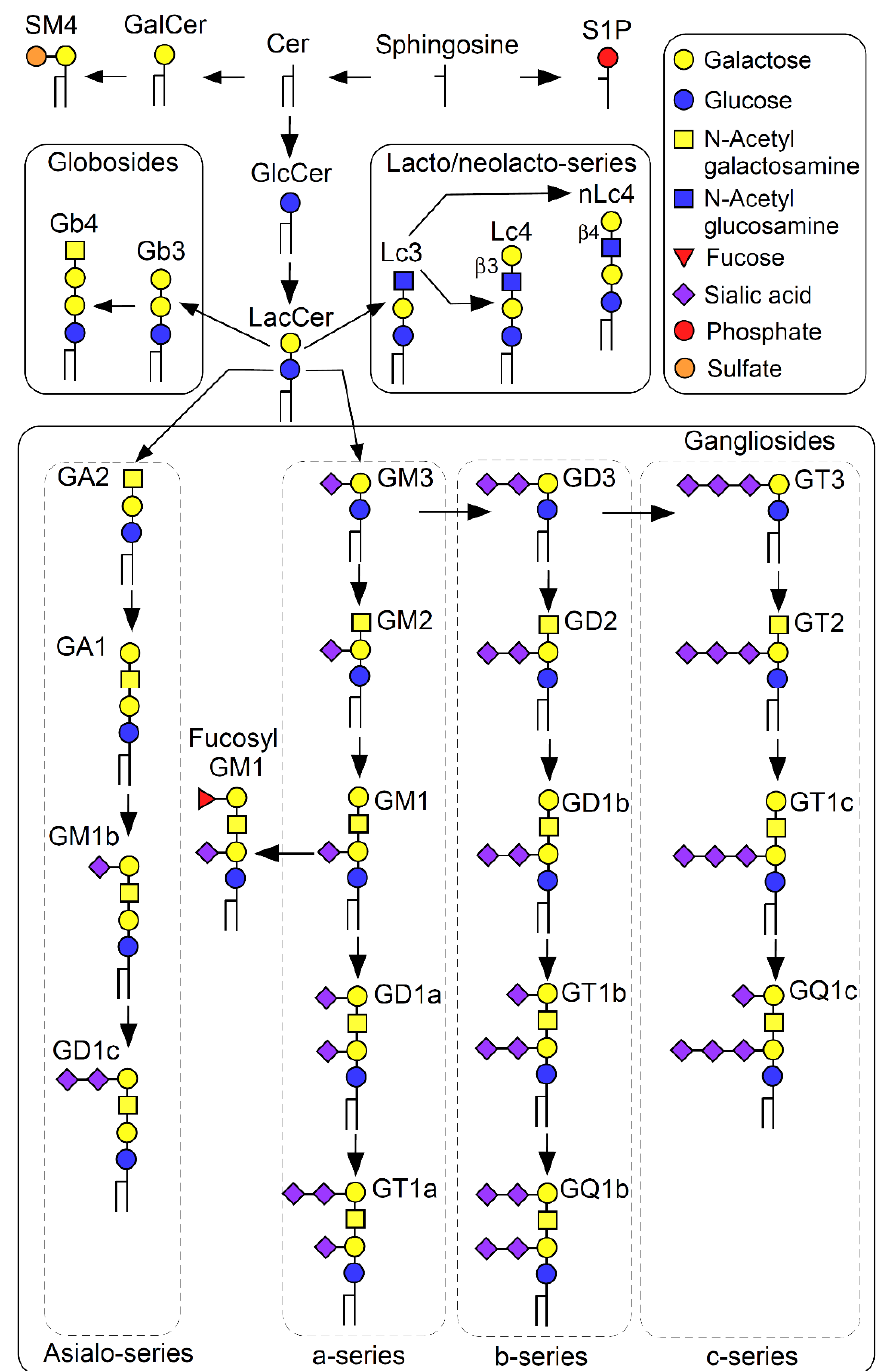
Figure 1. Schematic pathway of GSL biosynthesis. GSLs and the related molecules referred to in this review are shown.